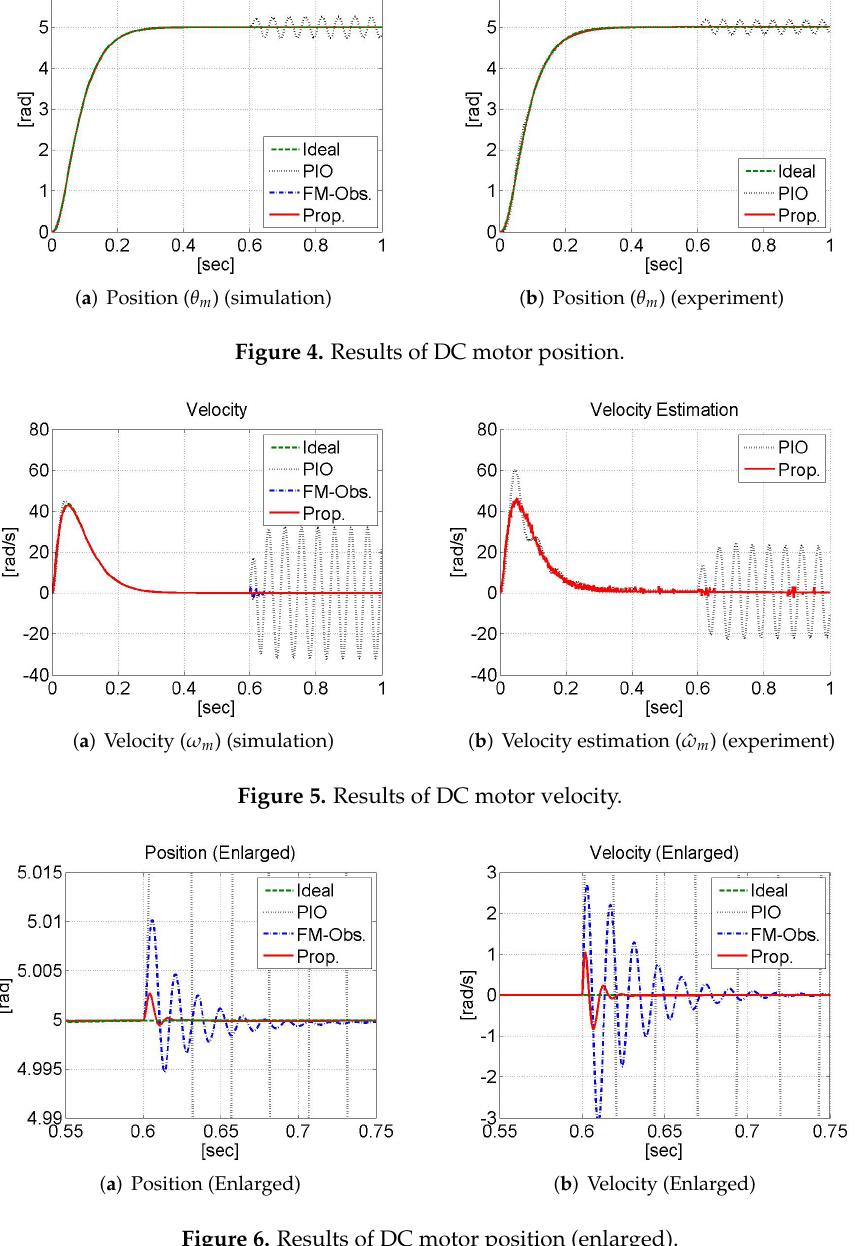
Figure 6. Results of DC motor position